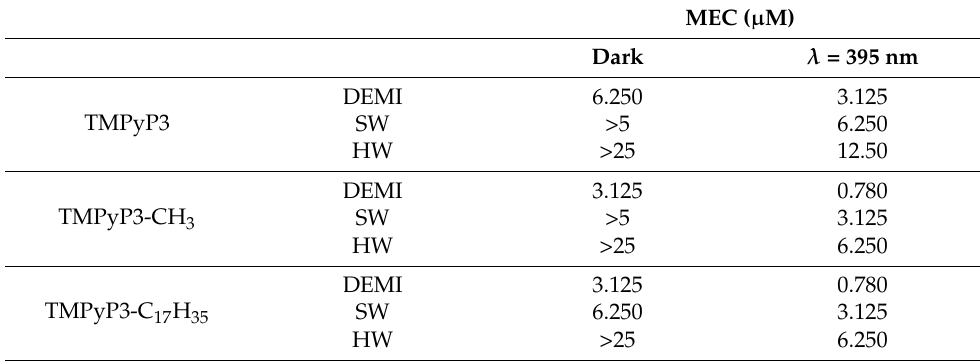
Table 2. Minimal effective concentration (MEC) of TMPyP3, TMPyP3-CH 3 , and TMPyP3-C 17 H 35 determined in DEMI after irradiation for 10 min with violet light (395 nm, 12 J/cm 2